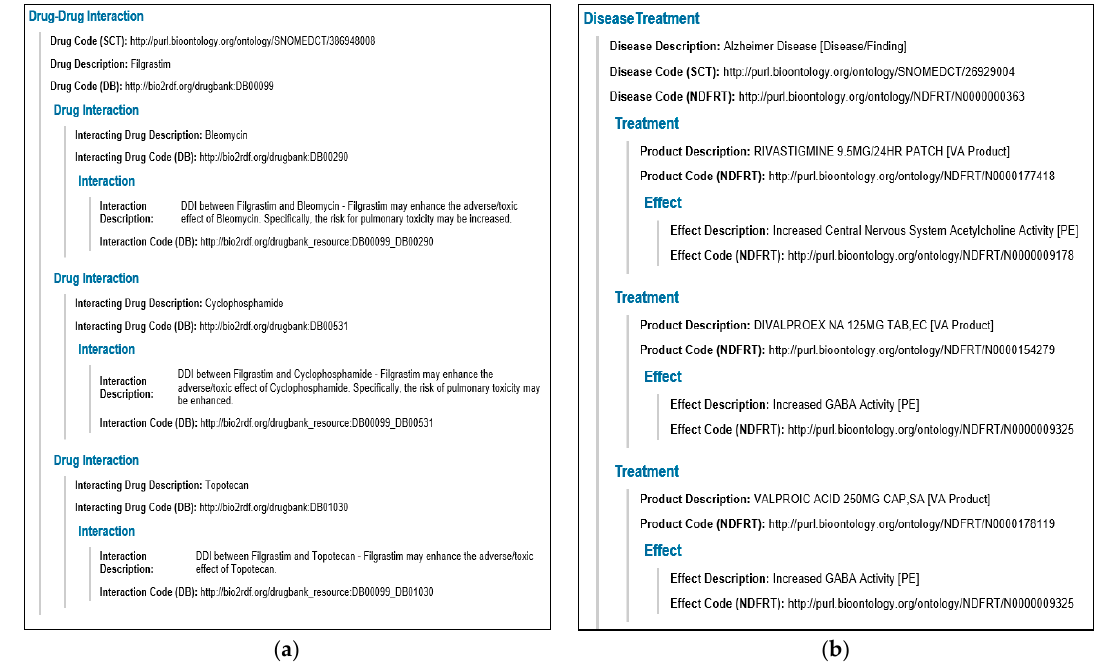
Figure 14. HTML representation of augmentation contents. ( a ) The augmentation content of the drug–drug interactions’ EHR augmentation, formatted according to the augmentation archetype CEN-EN13606-CLUSTER. DrugDrugInteraction.v1 . ( b ) The augmentation content of the disease-related treatments’ EHR augmentation, formatted according to the augmentation archetype CEN-EN13606-CLUSTER. DiseaseTreatment.v1 .